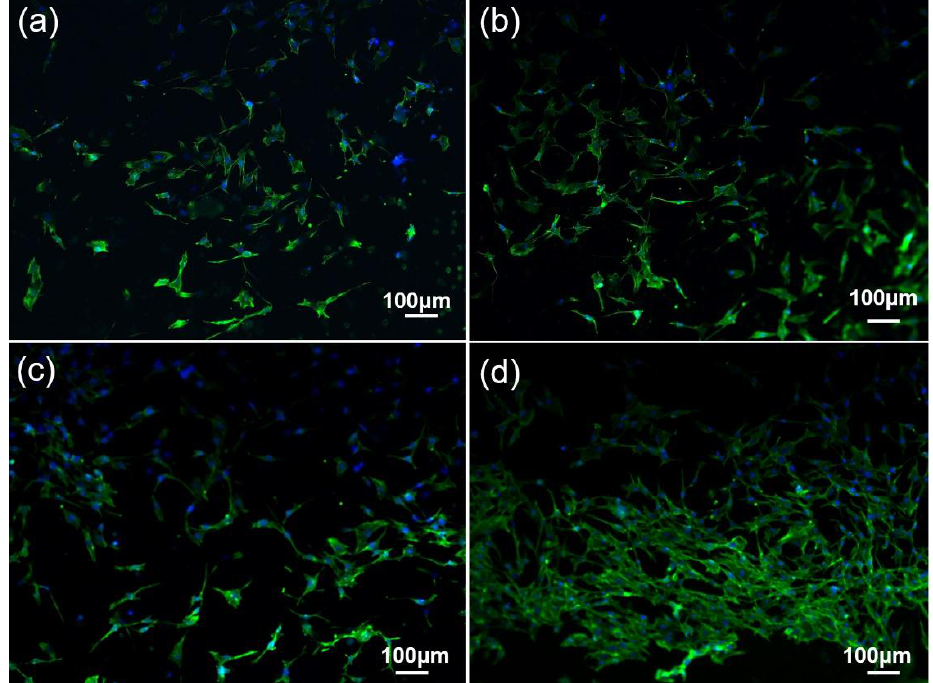
Figure 13. Representative fluorescent microscopic images of MC3T3-E1 cells grew for three days on the surface of sintered composites. ( a ) Ti-Ta-Nb-Zr/HA; ( b ) 0.5 CNTs; ( c ) 0.5 GNFs; ( d ) 0.4 CNTs/0.1 GNFs. The green and blue colors are showing the actin filament and nucleus, respectively.